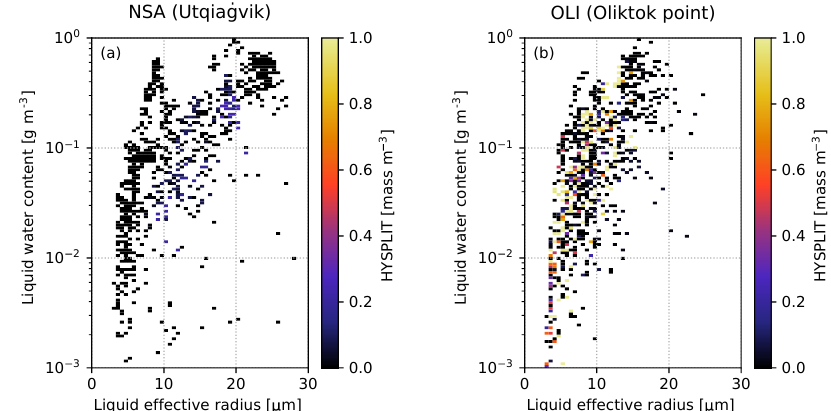
Figure 7. As Fig. 4, but with smaller bin size and mass concentration of local emission according to the HYSPLIT model for NSA (a) and OLI (b)